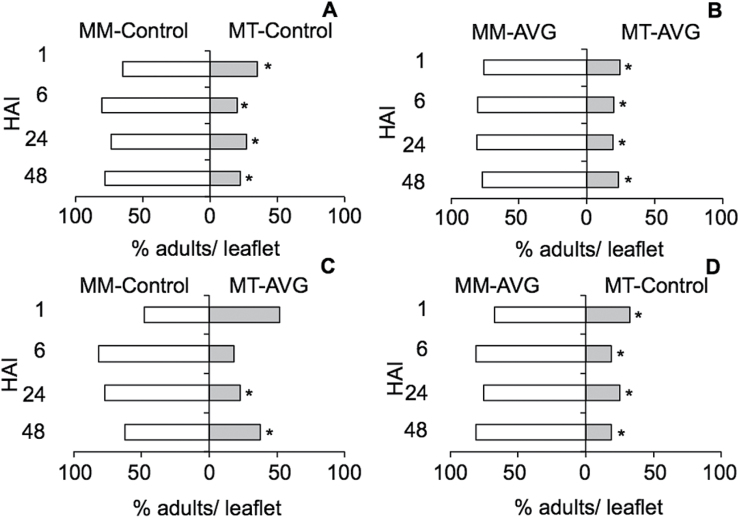
Aphid host preference between plants with and without Mi-1.2, in the presence or absence of an inhibitor of ethylene synthesis. The aphid-susceptible cultivar ‘MoneyMaker’ (MM) and the near-isogenic resistant line ‘Motelle’ (MT) were treated with AVG or mock treated with solvent (control), and choice assays were performed to determine whether AVG influenced the aphids’ ability to discriminate between the two genotypes (20 aphids per area; six arenas per comparison). The percentage of adults that were located on treated plants versus controls was recorded at 1, 6, 24, and 48 HAI. Comparisons labelled with an asterisk (*) were statistically different at α=0.05 according to one-sided matched-pair comparisons.